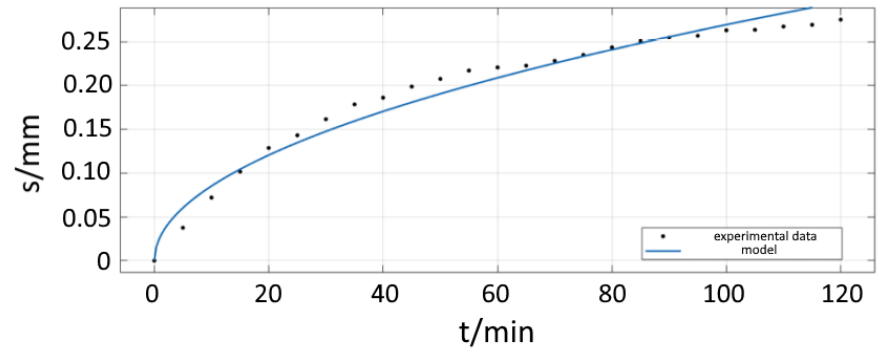
Figure 15. Model for phase I of interface diffusion.